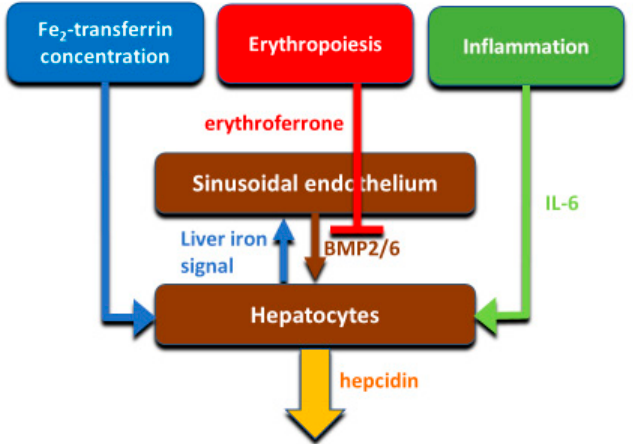
Figure 4. Iron, erythropoiesis and inflammation regulate hepcidin transcription through their effects on hepatocytes and by modulating the paracrine signaling between hepatic sinusoidal endothelium and hepatocytes.